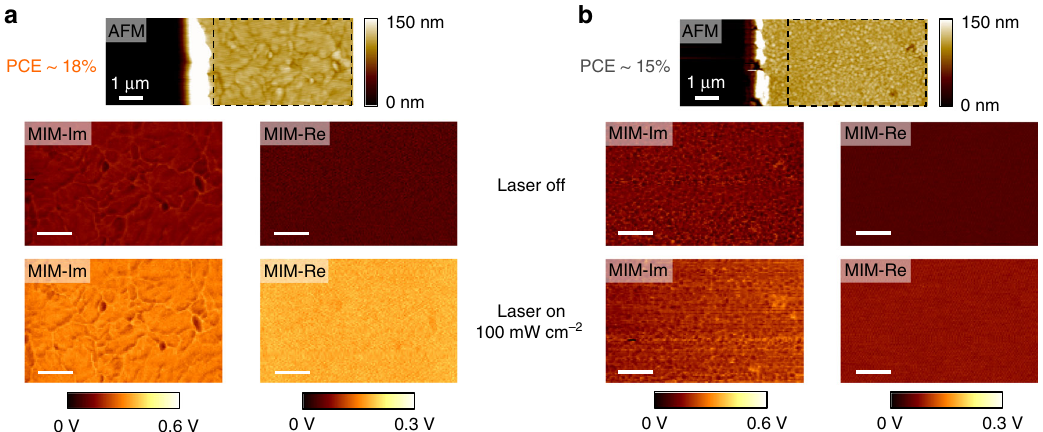
Fig. 2 Nanoscale photoconductivity imaging on MAPbI 3 . a AFM (top) and MIM-Im/Re images (inside the black dashed rectangles in the AFM data) when the 532-nm laser is turned off (middle) and on (bottom) for the 18% PCE sample. The same results for the 15% PCE sample are shown in b . The scale bars in a and b are 1 μ